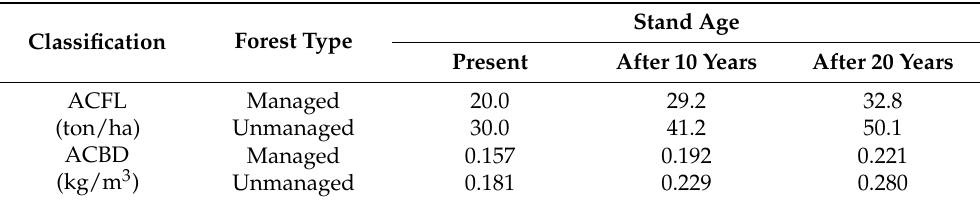
Table 6. Estimation of canopy fuel loads by scenarios of managed stands (trees per ha (TPH) = 900, site index (SI) = 13), and unmanaged stands (TPH = 1600, SI = 12). Stand Age Classification Forest Type Present After 10 Years After 20 Years ACFL Managed 20.0 29.2 32.8 (ton/ha) Unmanaged 30.0 41.2 50.1 ACBD Managed 0.157 0.192 0.221 (kg/m 3 ) Unmanaged 0.181 0.229